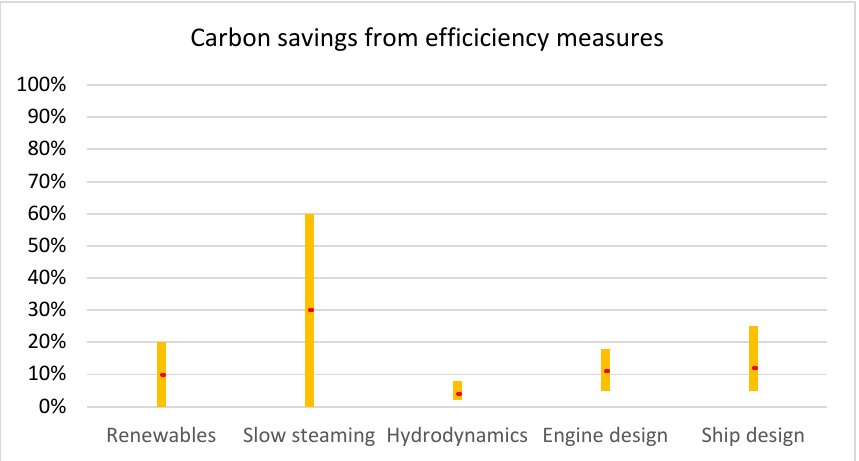
Figure 20. Amounts of GHG emissions that can be reduced by including a variety of measures